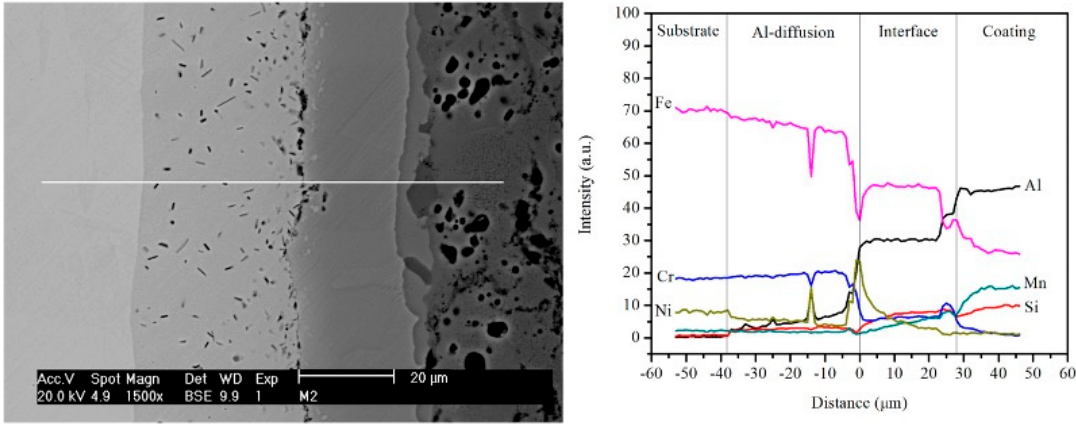
Figure 6. EDS line concentration profiles of a sample processed at 850 °C and 15 MPa for 7200 s.